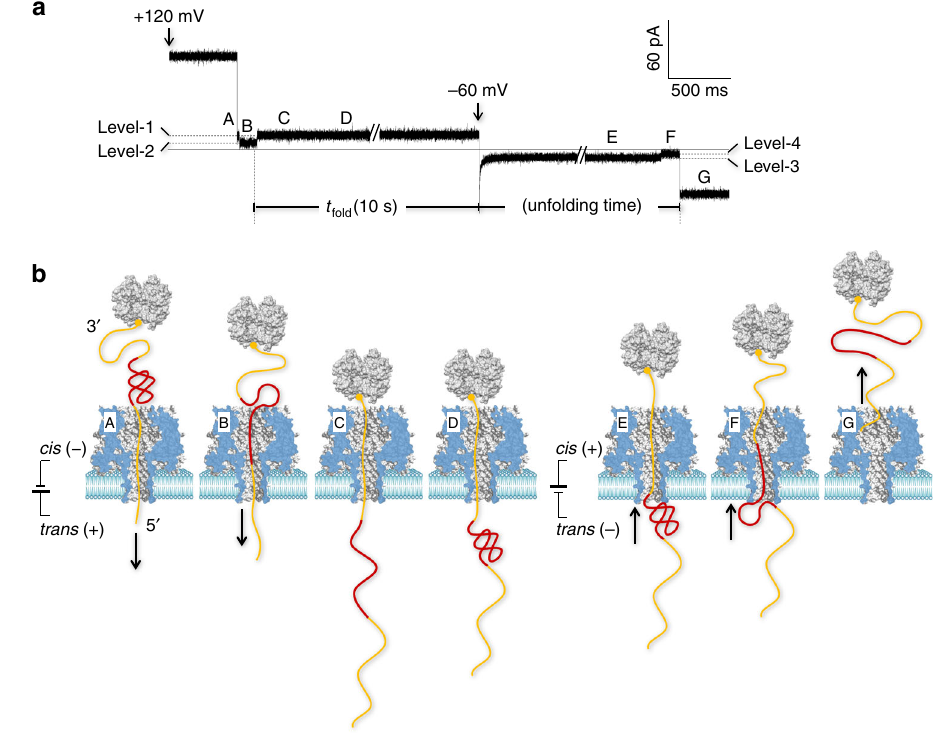
Fig. 2 Nanopore snapshot for T2 RNA pseudoknot formation. a Stepwise multi-level nanopore current signature generated by a complex probe under the +120 mV/ t fold = 10 s/ − 60 mV protocol (the probe was trapped at + 120 mV, the folding time t fold was 10 s, and the folding structure was unfolded at − 60 mV). b Model cartoons showing the entire trapping – folding – unfolding procedure revealed by the signature in a : translocation of the 5 ʹ DNA tag (A, Level-1), disruption while translocating T2 RNA (B, Level-2), translocation and immobilization of the 3 ʹ DNA tag (C, Level-1), folding of the pseudoknot from the single-stranded RNA on the trans side (D) for a pre-de fi ned folding time ( t fold = 10 s), unfolding of the folding structure under back-pulling at − 60 mV while the 3 ʹ DNA tag remains in the pore (E, Level-3), translocation of the partially unfolded T2 RNA through the pore (F, Level-4), and a fully disrupted probe pulled out of the pore and back to the cis solution (G). The time from the beginning of negative voltage ( − 60 mV) application to the block end is